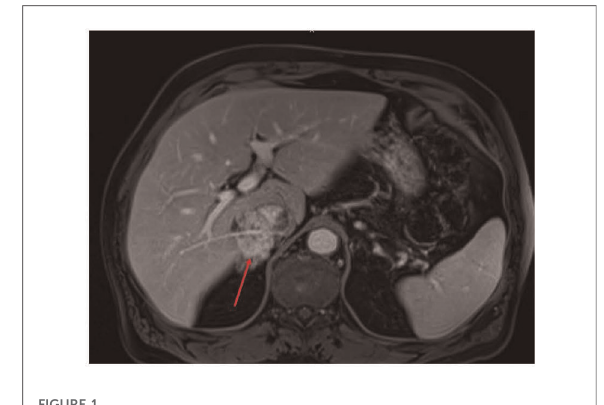
FIGURE 1 Pre-operative MRI showing involvement of the retro-hepatic IVC by leiomyosarcoma (red arrow). IVC, inferior vena